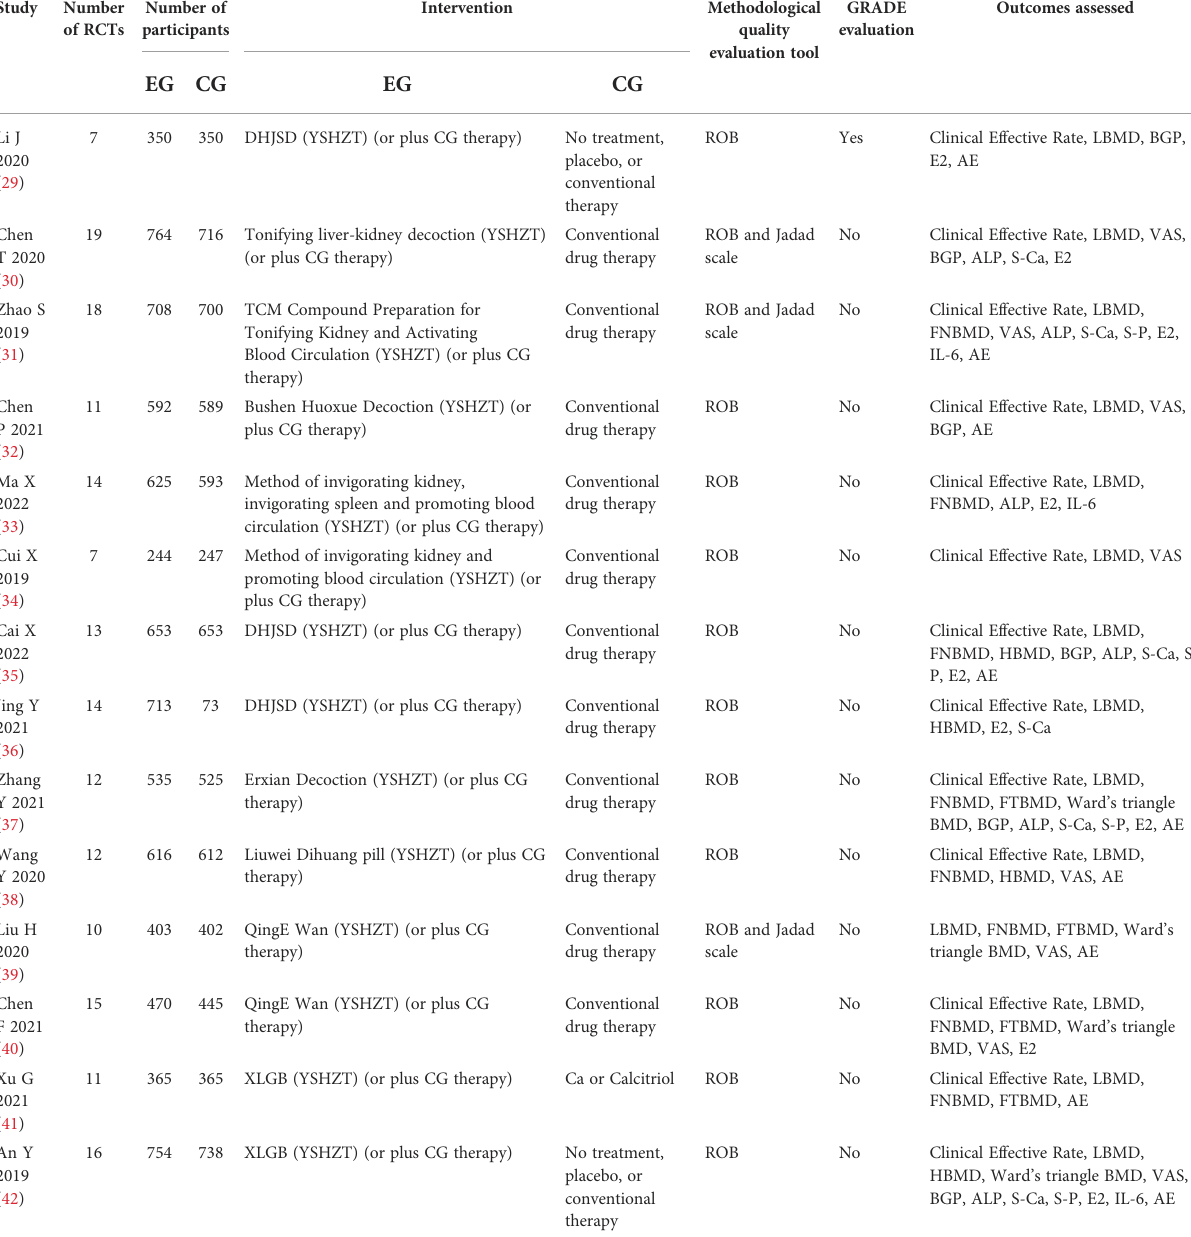
TABLE 1 Characteristics of the systematic reviews or meta-analyses included in the overview. Study Number Number of of RCTs